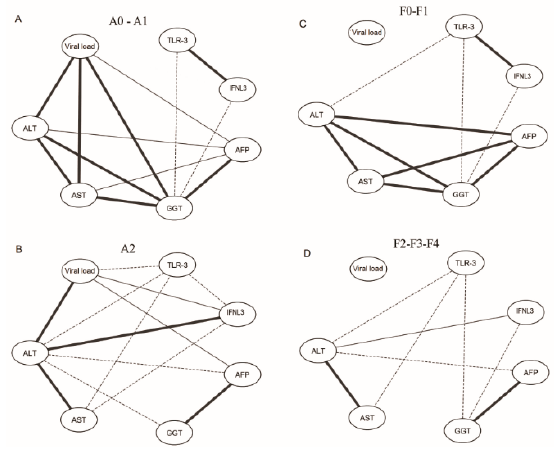
Figure 5. Interaction networks for the biomarkers analyzed among patients with degrees of necroin- flammatory activity ( A ) A0-A1 and ( B ) A2; fibrosis scores ( C ) F0-F1 and ( D ) F2-F3-F4. Correlation values were categorized and are represented by the connecting lines (edges). The r values were used to categorize the correlations into strongly positive (r ≥ 0.68; solid bold line), moderately positive (0.36 ≥ r ≤ 0.67; continuous thin line) and negative ( − 0.37 ≥ r; dashed line). Pearson correlation.